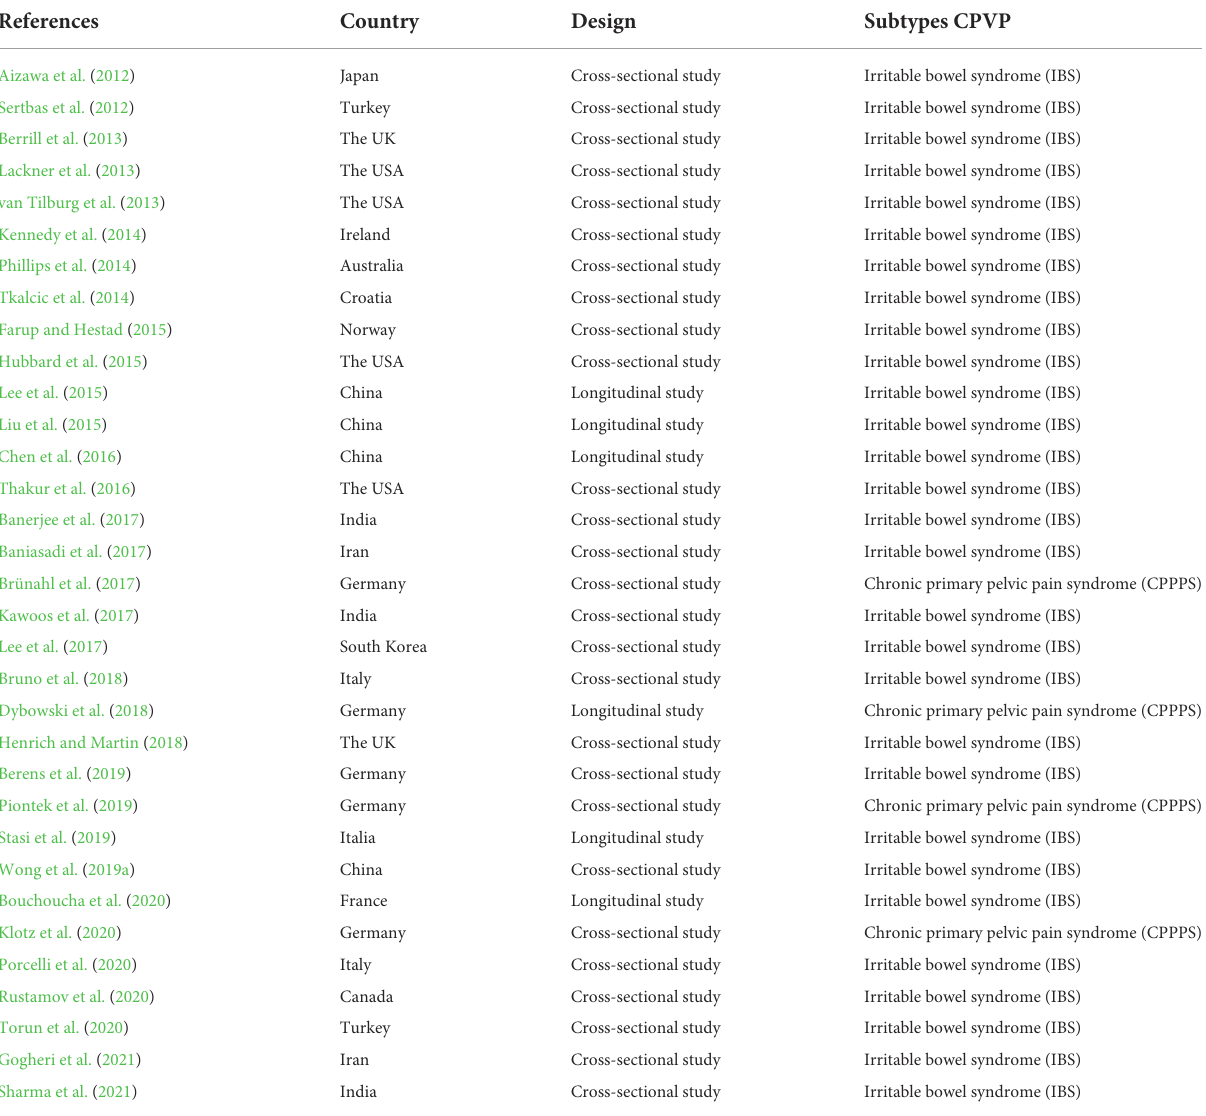
TABLE 1 Characteristics of the studies included in the